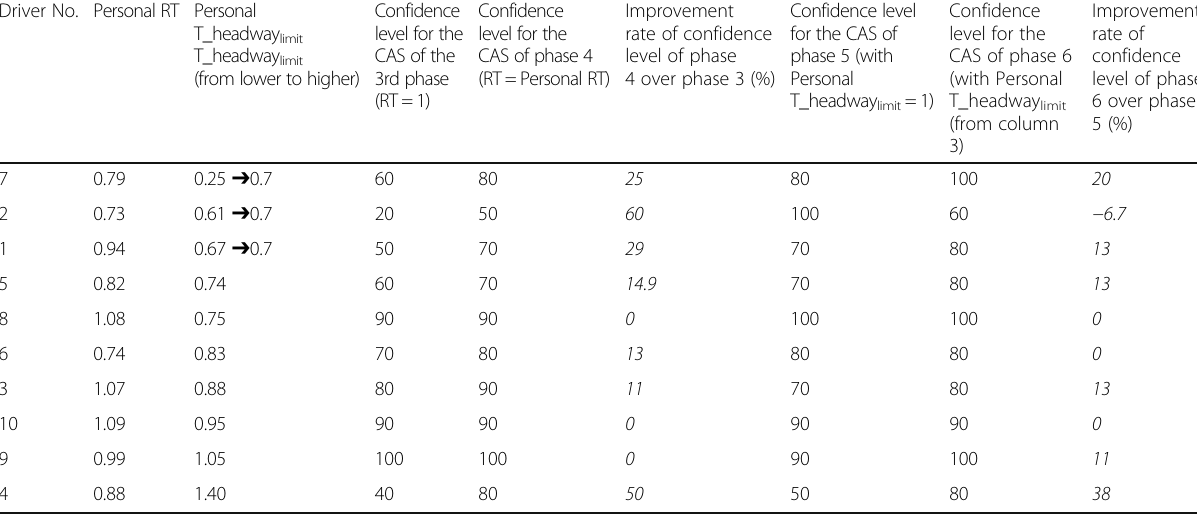
Table 3 Comparative results of the total confidence level per user and driving phase with the CAS Driver Νο . Personal RT Personal